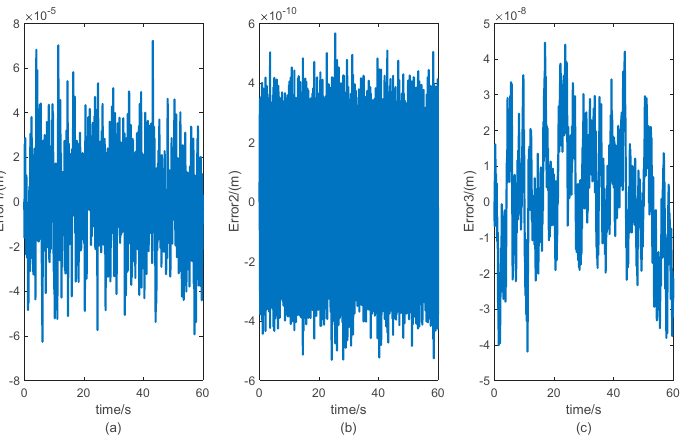
Figure 5. Curves of the error signals without faults. ( a ) Curve of error signal without faults of Agent 1. ( b ) Curve of error signal without faults of Agent 2. ( c ) Curve of error signal without faults of Agent 3.